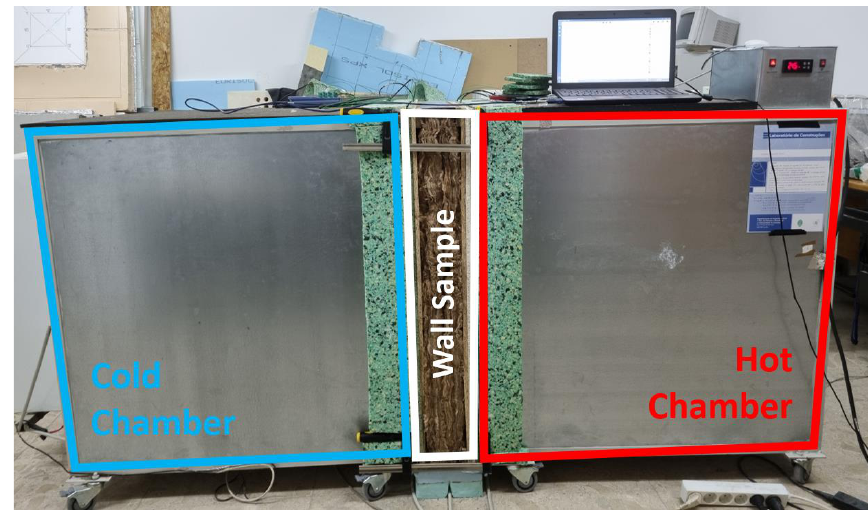
Figure 3. Cold and hot boxes apparatus used in the experiments.